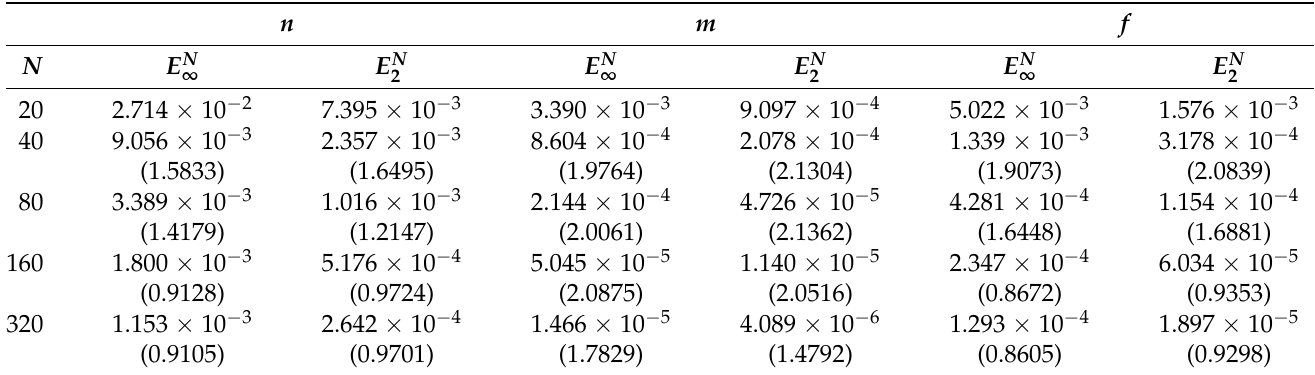
Table 7. Errors and convergence rates (bracketed) in different norms, Example 3.